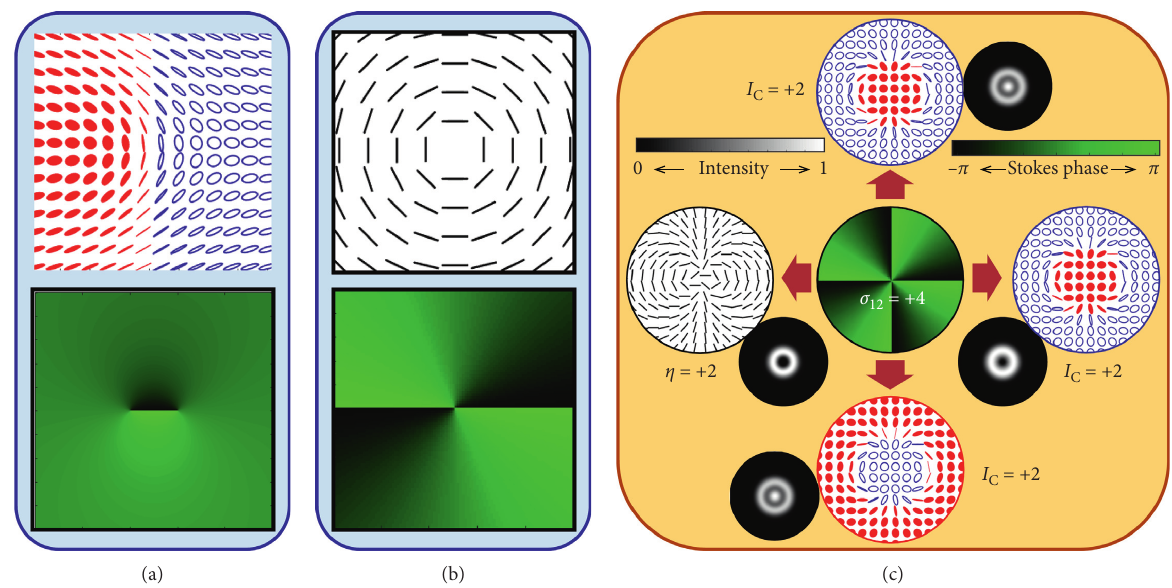
Figure 9: Polarization distribution and Stokes phase of (a) dipole field and (b) a V-point field. (c) Limitations in Stokes phase: the Stokes phase has same spatial distribution for a V-point of index η � 2, right-handed and left-handed bright C-point of index I C � 2, and a dark C- point of index I C � 2, and thus, the Stokes phase is